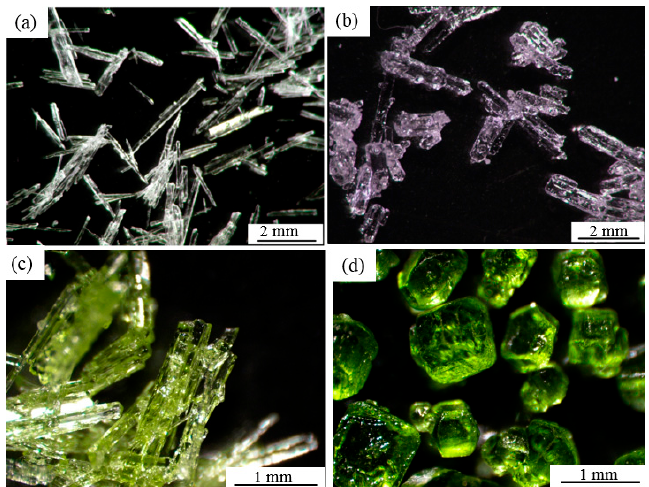
Figure 3. Morphology of crystalline products and commercial products. ( a ) ZnSO 4 ·7H 2 O crystals by MD integrated with crystallization; ( b ) commercial ZnSO 4 ·7H 2 O; ( c ) NiSO 4 ·7H 2 O crystals by MD integrated with crystallization; ( d ) commercial NiSO 4 ·6H 2 O.